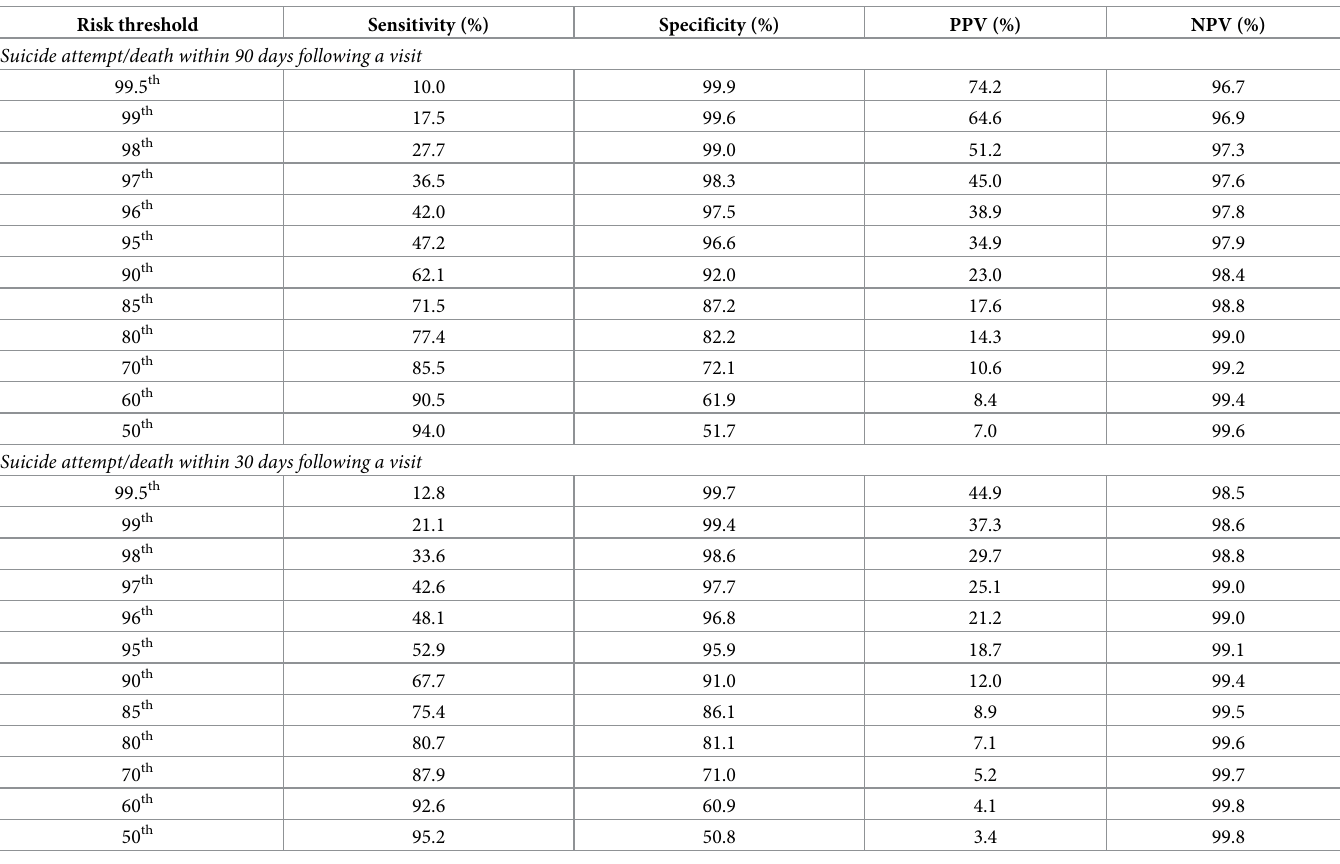
NPV, negative predictive value; PPV, positive predictive value. Model performance metrics were based on ensemble